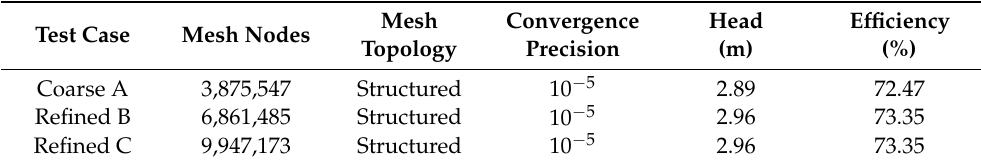
Table 2. Grid independent